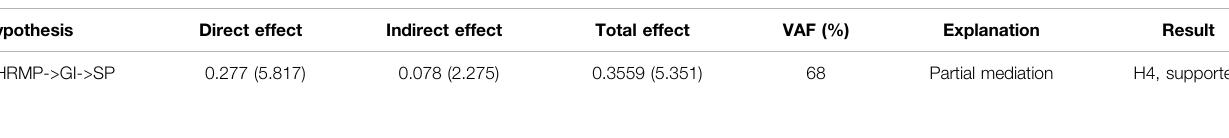
TABLE 6 | Mediation